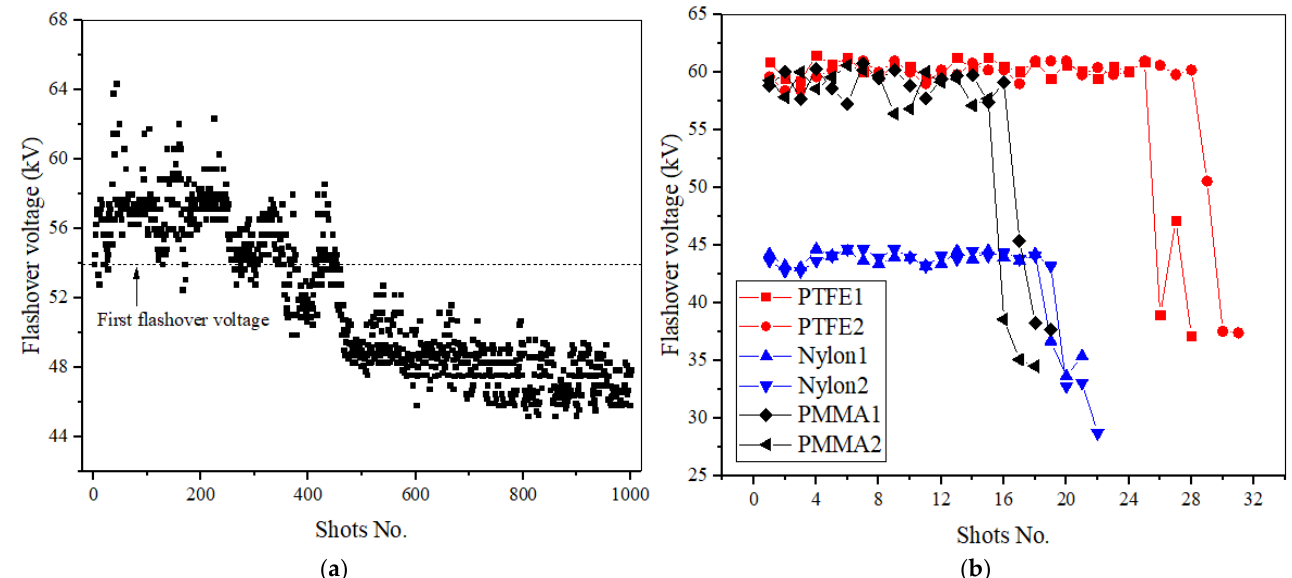
Figure 8. Successive flashover voltage under 1 Hz pulses in ( a ) air and ( b ) SF 6